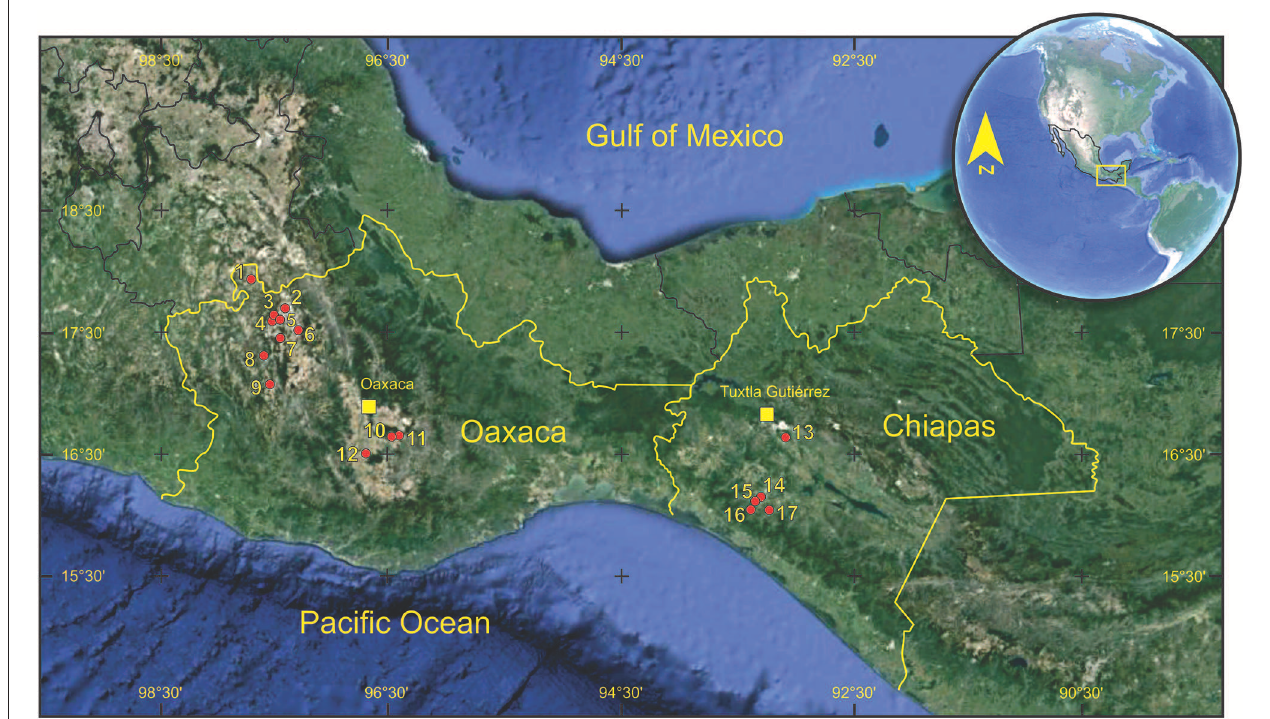
FIGURE 1 | Main Late Pleistocene equid localities from Oaxaca and Chiapas. 1. Chazumba, 2. Concepción Buenavista, 3. Río Sabinal, 4. Río Salado, 5. Cañada del Misterio, 6. Sandage, 7. Río Tejupam; 8. Yolomécatl, 9. Magdalena Peñasco, 10. Güilla, 11. San Dionisio Ocotepec, 12. San Martín de los Cansecos, 13, Nandachuquí, 14. Los Mangos, 15. Gliptodonte, 16. La Simpatía, 17. La